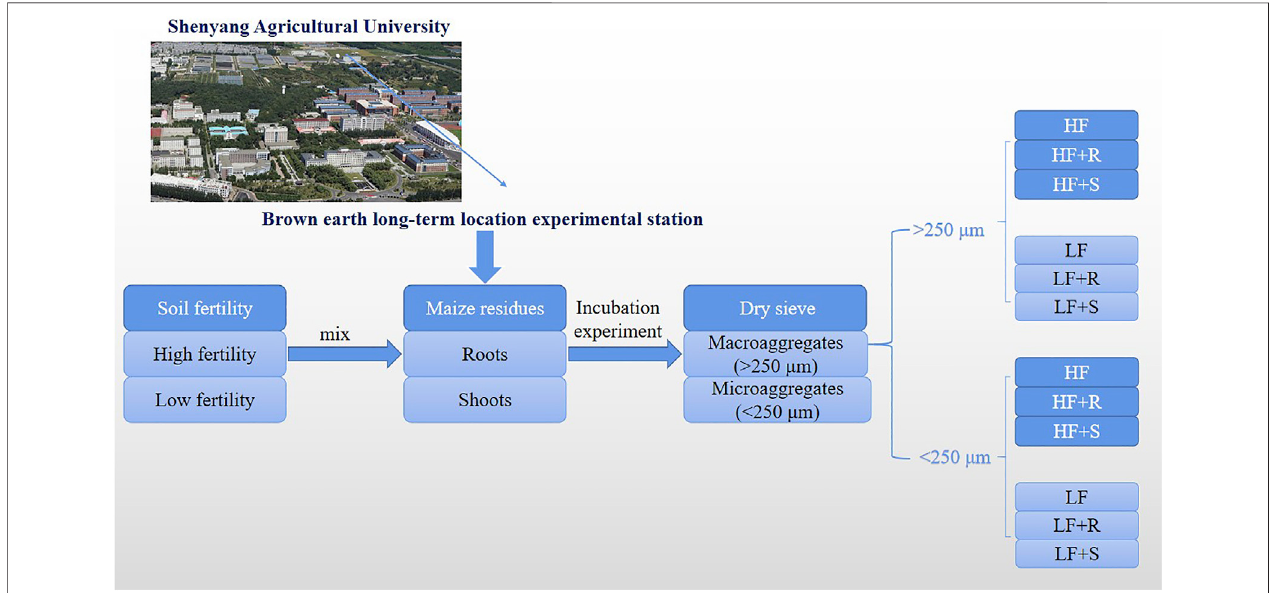
FIGURE 1 | Location of tested materials and treatments in this